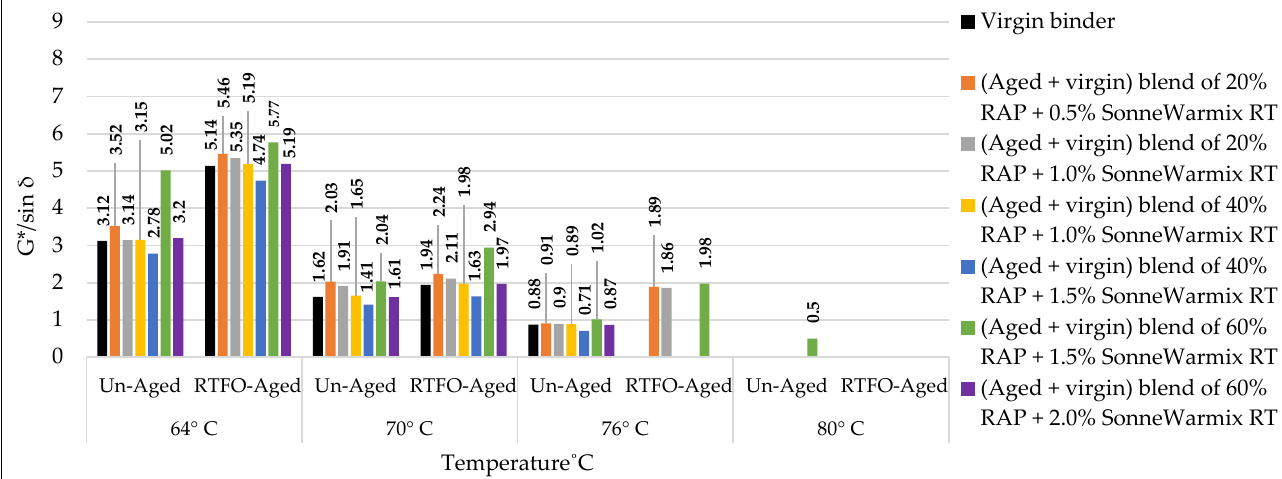
Figure 24. Rutting index (G*/sin δ ) for the aged blends of binders rejuvenated by SonneWarmix RT TM .